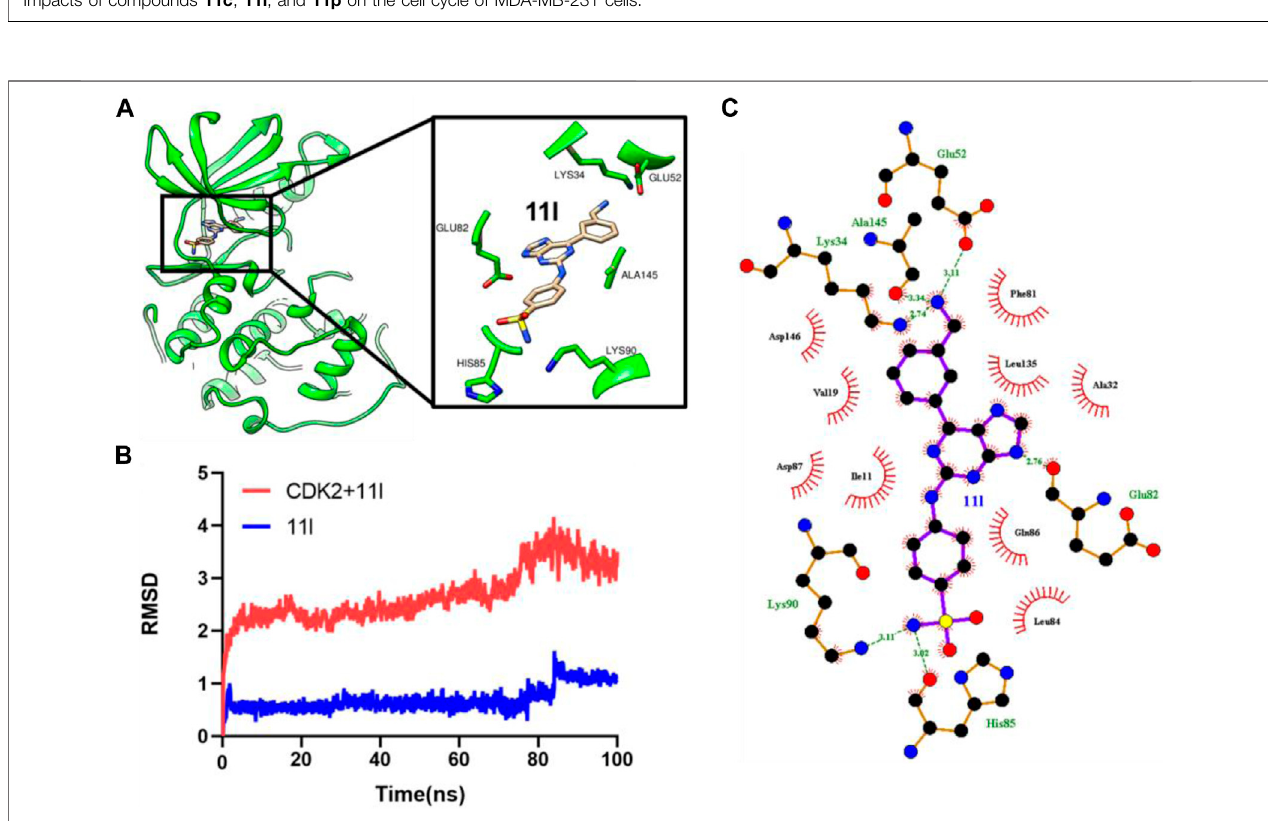
FIGURE 4 | (A) Predicted binding mode of 11l in CDK2 from MD simulation. The key residues of CDK2 are highlighted and colored in green. (B) RMSD values of protein – ligand complex and 11l during MD simulation. (C) Interacting residues between 11l and